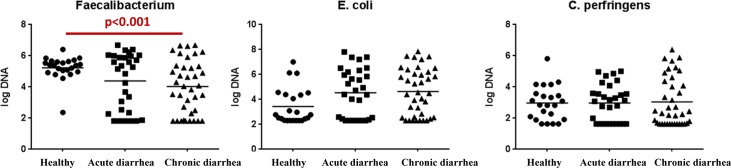
Quantitative PCR results.